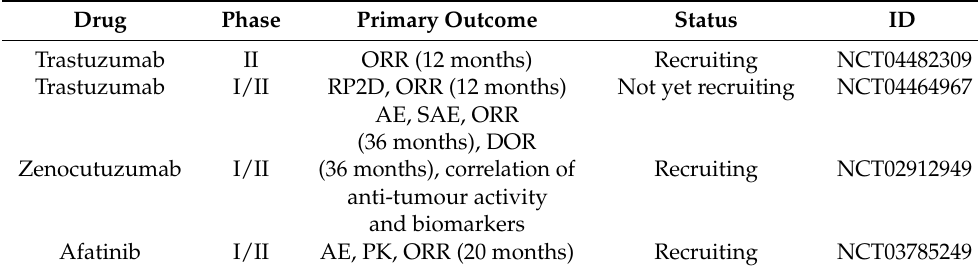
Table 1. Ongoing clinical trials targeting the HER2